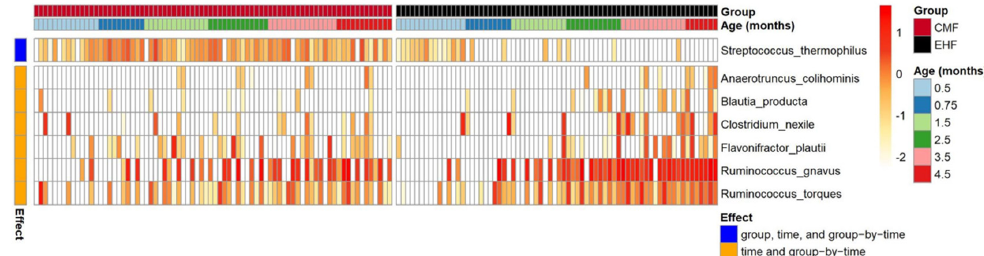
Figure 4. Heatmap of bacterial species from 0.5 to 4.5 months in CMF (red bar) and EHF (black bar) groups. Red signifies higher abundance. Linear mixed effects models revealed significant group × time, group and time effects (blue) for Steptococcus thermophiles and significant group × time and time effects (orange) for Ruminococcus gnavus , Blautia producta , Ruminococcus torques , Clostridium nexile , Flavonifractor plautii , and Anaerotruncus colihominis.